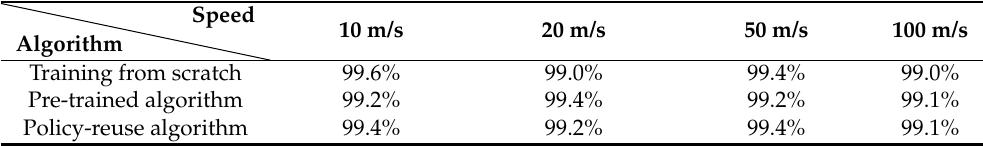
Table 4. Success rate in uniform-motion destination